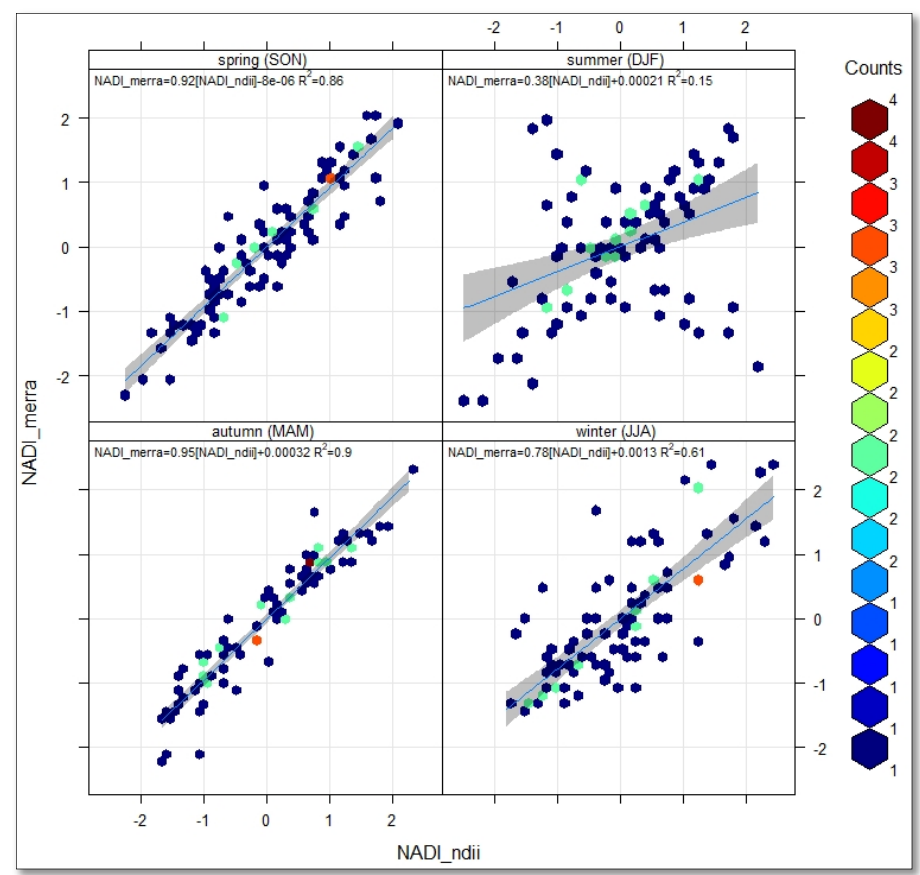
Figure 6. Seasonal correlation of NADI-NDII and NADI-MERRA–2 over the Luvuvhu River Catchment between 1986 and 2016.